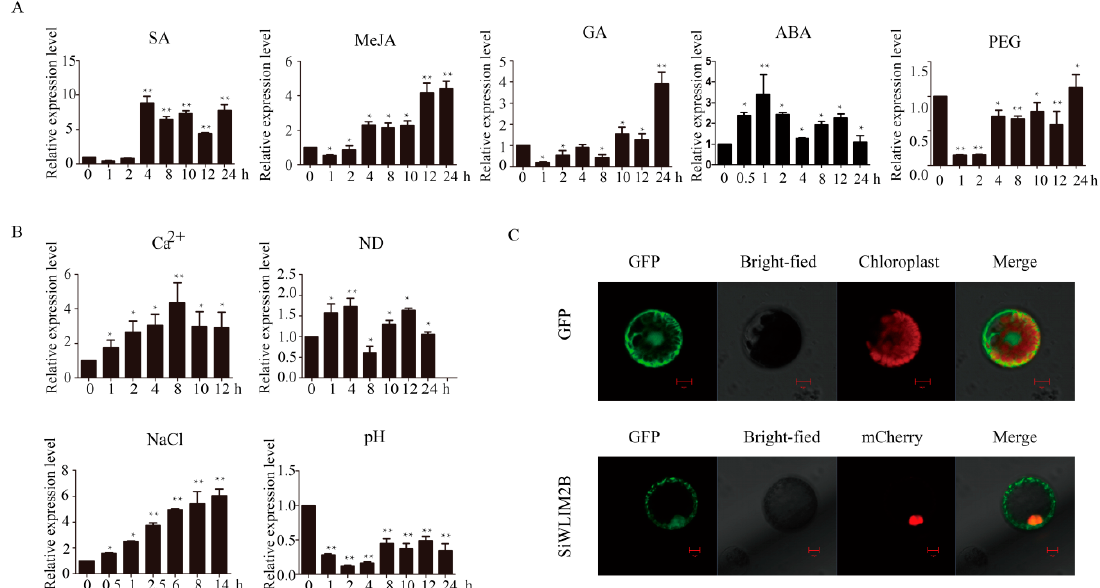
Figure 4. Molecular characteristics of the SiWLIM2b gene and Subcellular localization of the SiWLIM2b protein. ( A ) SiWLIM2b expression in seedlings treated with ABA, SA, GA, MeJA or PEG. ( B ) SiWLIM2b expression in seedlings in the presence of Ca 2+ , nitrogen-deficient conditions, NaCl or high pH. ( C ) Subcellular localization analysis of the SiWLIM2b protein in tobacco protoplasts. The SiWLIM2b-GFP fusion protein is mainly distributedin the cytoplasm and nucleus. Vertical bars in ( B , C ) indicate ± SE of three replicates. ** indicates significant differences in comparison with the control lines at p < 0.01. * indicates significant differences in comparison with the control lines at p < 0.05. (C) Scale bars = 10 µ